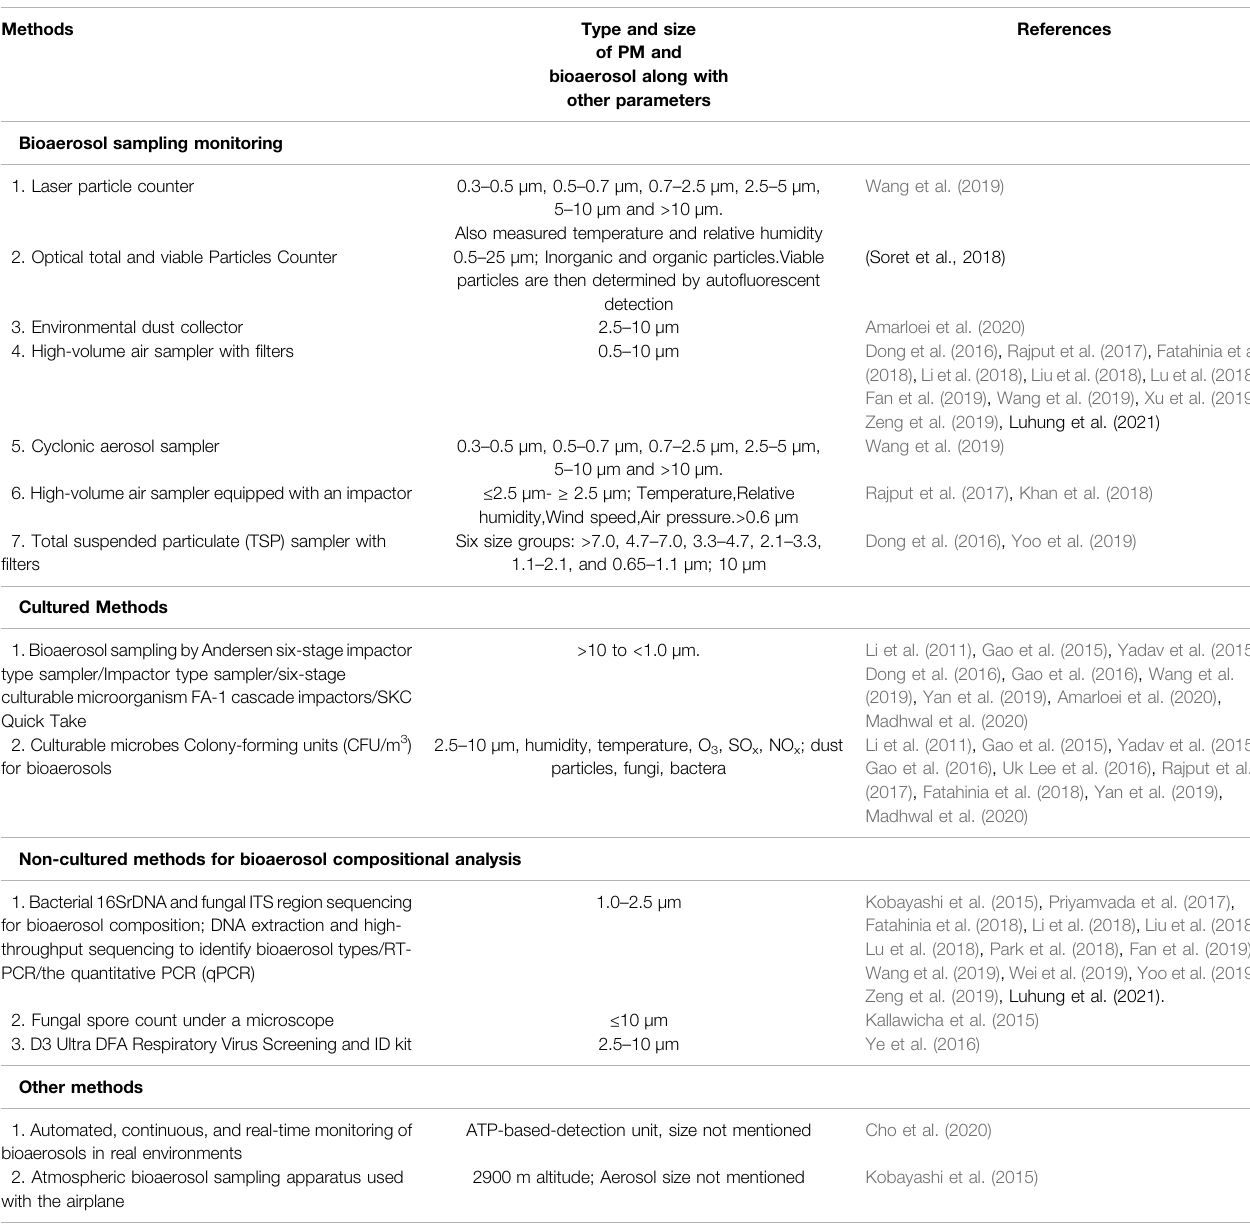
TABLE 2 | Methods of bioaerosol collection from air particulate matter identi fi ed from this